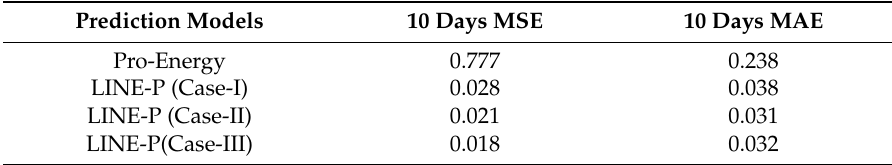
Table 3. Average MSE and MAE over 10 days for LINE-P (all cases) and Pro-Energy.